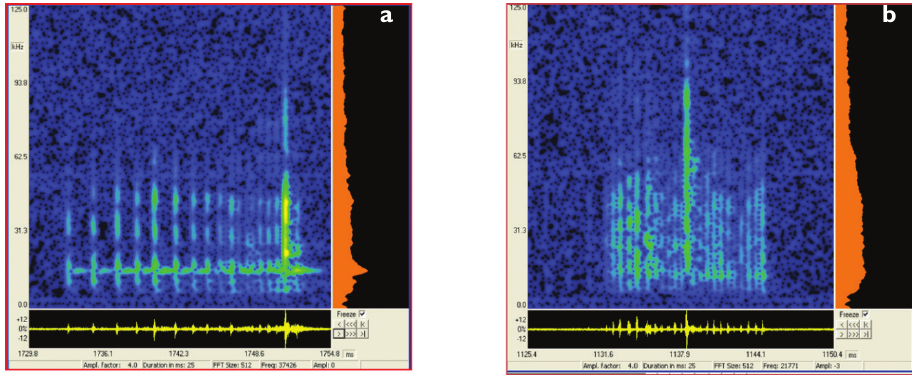
Figure 10. Spectrograms of two Graphipterus species: G. serrator and G. multiguttatus